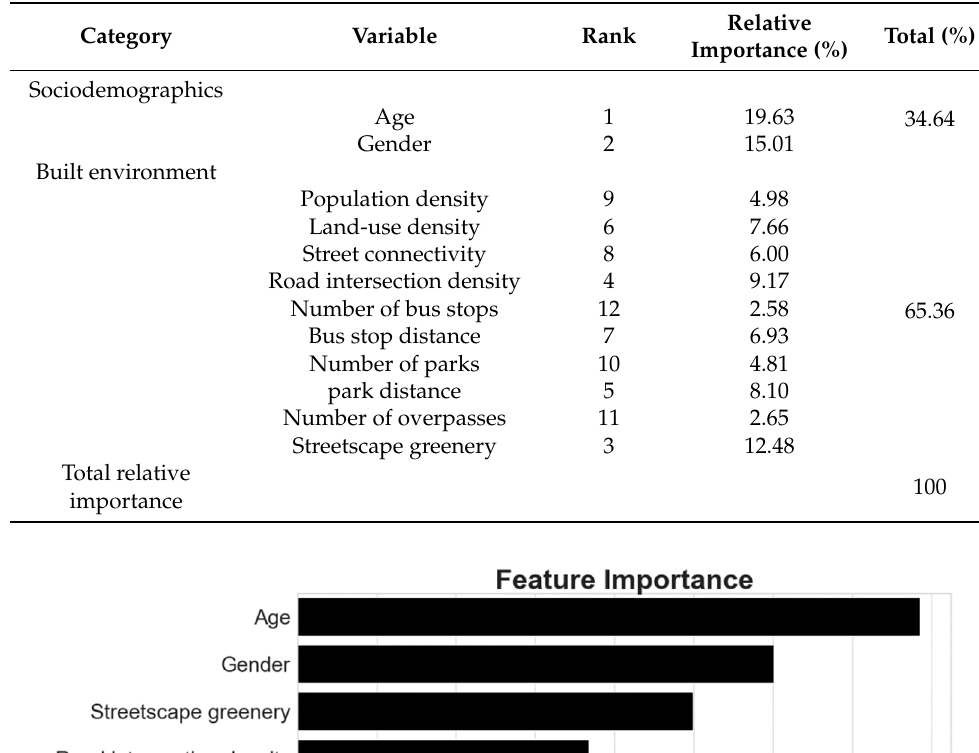
Table 3. The random forest algorithm calculates the relative relevance of predictor variables.